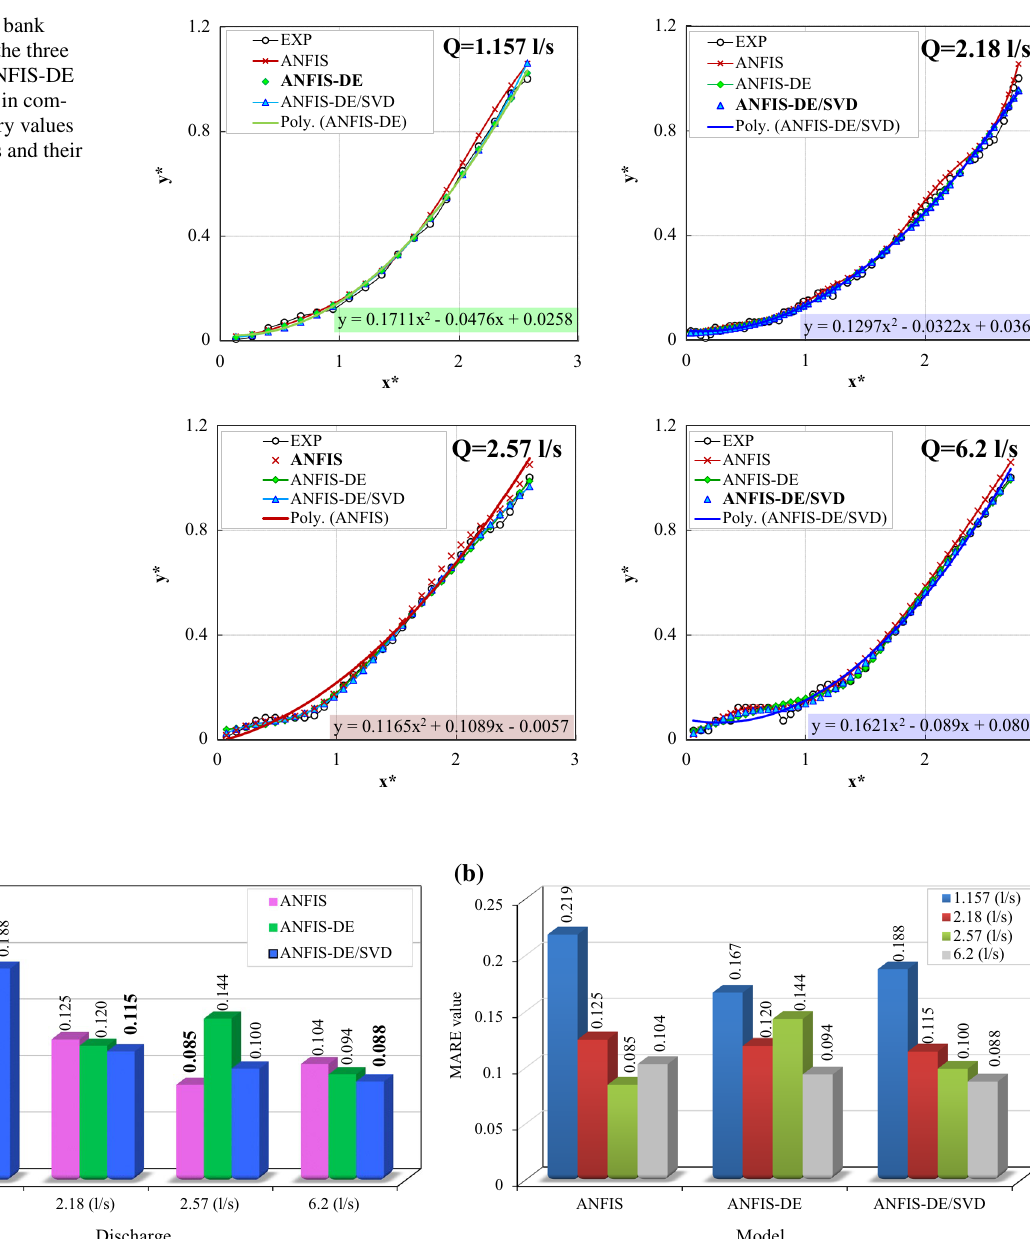
Fig. 8 Stable channel bank profiles predicted by the three models of ANFIS, ANFIS-DE and ANFIS-DE/SVD in com- parison with laboratory values at different discharges and their fitted curves